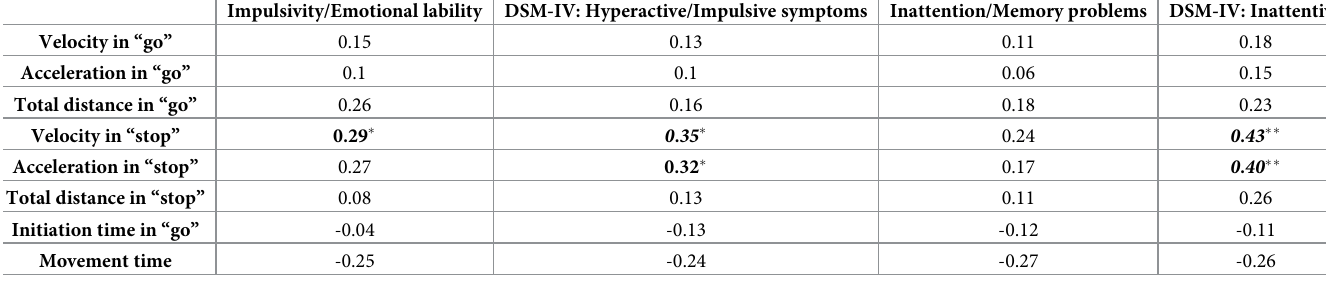
Table 15. Values of Spearman’s ρ for correlations between mouse movement and impulsivity/inattention measures.